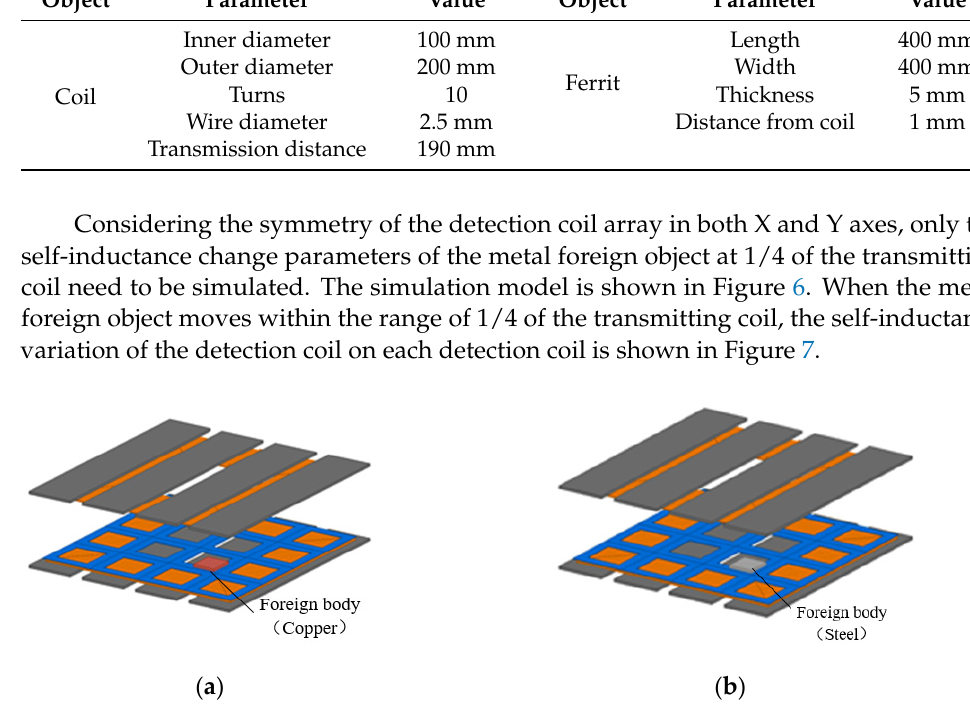
Figure 6. Simulation model. ( a ) Copper sheet as a metal foreign object; ( b ) Steel sheet as a metal foreign object.